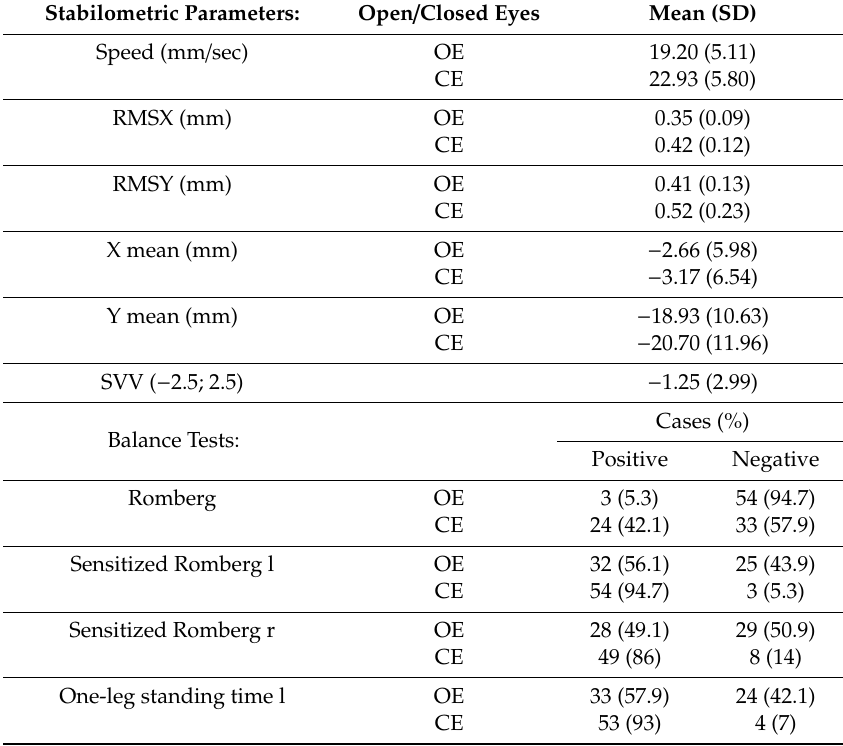
Table 2. Stabilometric parameters and balance tests of patients with moderate-severe impact of FMS. Stabilometric